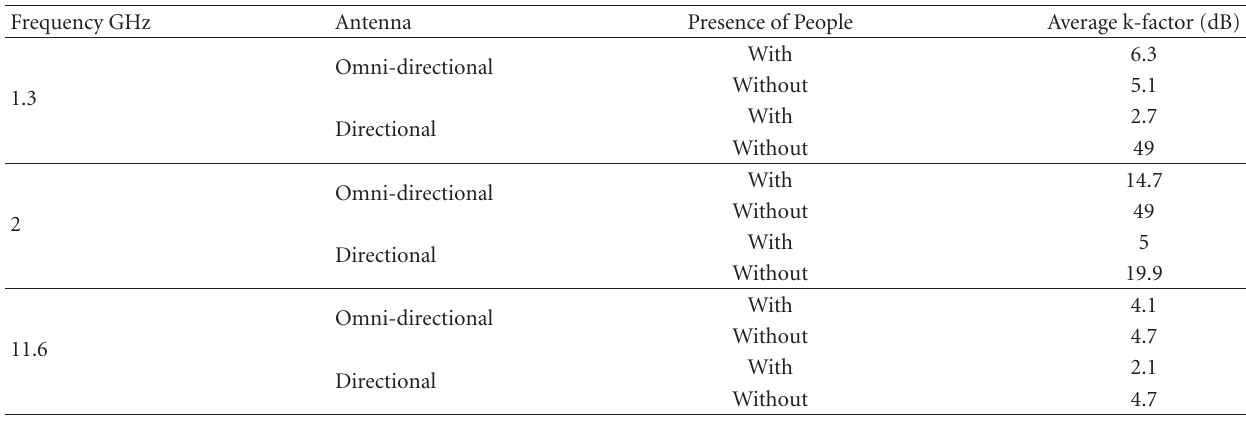
Figure 10: Dependency of joint amplitude and delay distributions on the shape factor: (a) r = 0 . 5 (b) r = 0. Table 4: Rician k-factor for measurements conducted in the presence and absence of people.